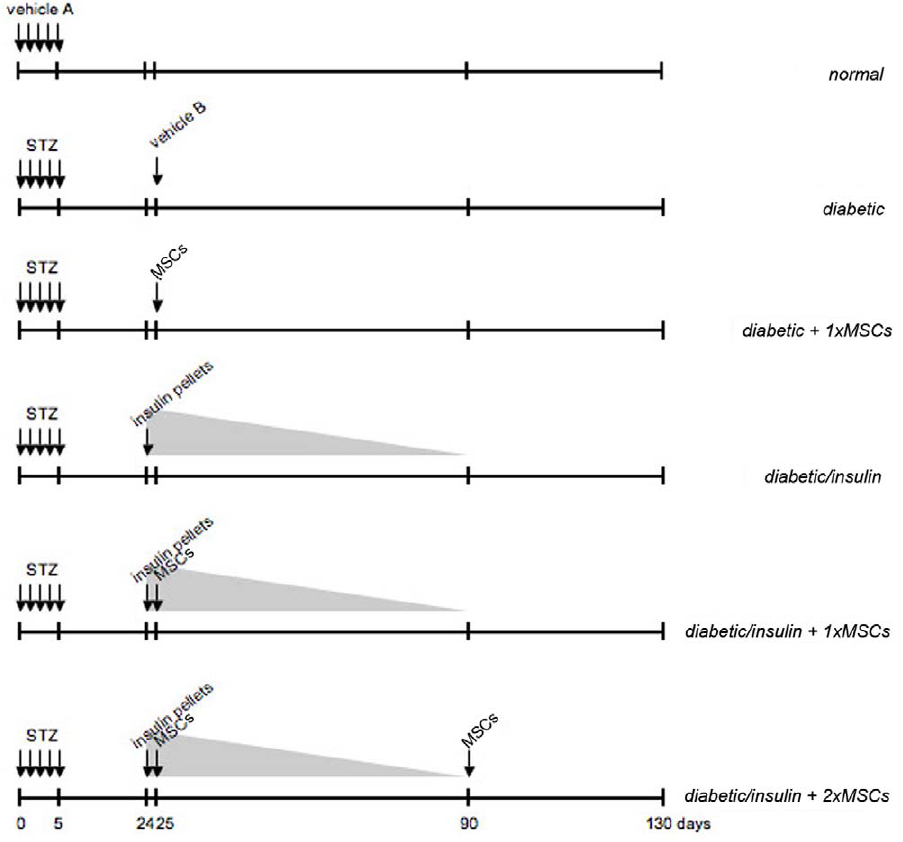
Figure 1. Experimental groups. Vehicle A: 0.1 M citrate buffer, pH 4.5. STZ: intraperitoneal 40 mg/kg/day, for five consecutive days. Vehicle B: 5% mice plasma. MSCs: intravenous 0.5 6 10 6 healthy donor bone marrow-derived MSCs resuspended in 0.2 mL vehicle B. Insulin pellets: subcutaneous implantation of two timed-release porcine insulin pellets per animal. Triangle represents exogenous insulin levels.